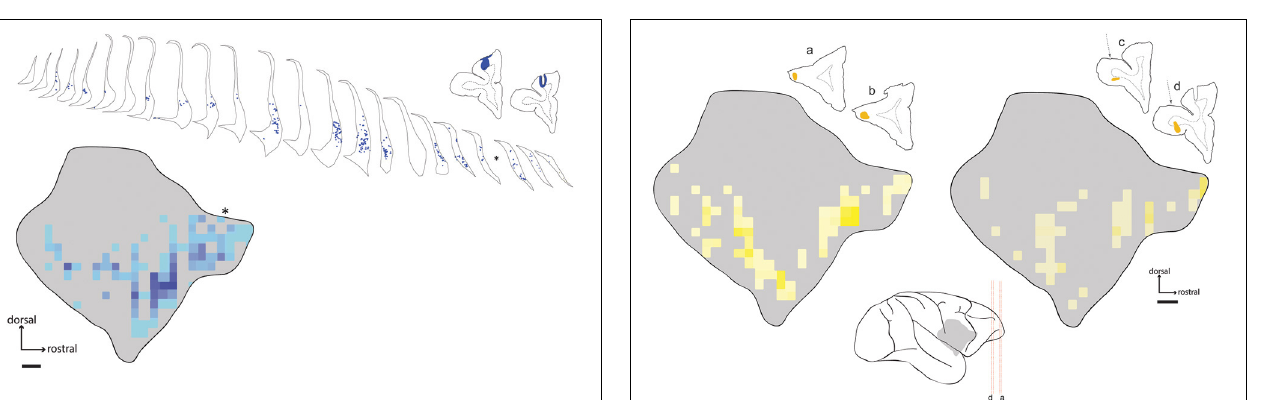
FIGURE 4 | Distribution of labeled neurons in claustrum following tracer injection in area 9. Line drawings show placement of fast blue injection in case FR04, along with the resulting retrogradely labeled cell bodies in the ipsilateral claustrum. Asterisk indicates the position of a single tissue section lost due to slide damage during coverslipping. Scale bar = 1mm.